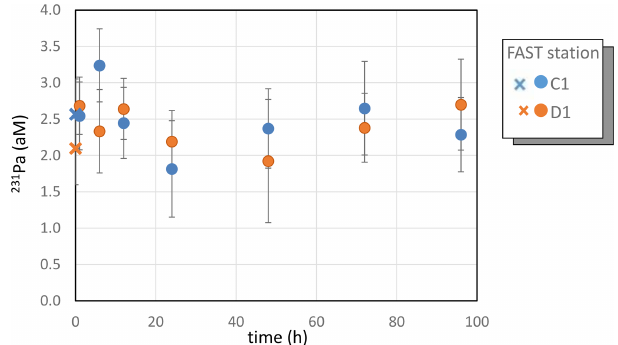
Figure 4. Dissolved Pa during the FAST experiments. Error bars correspond to the analytical uncertainties (2 σ n , where σ n is the error of the mean). Crosses correspond to samples collected before dust addition ( t =